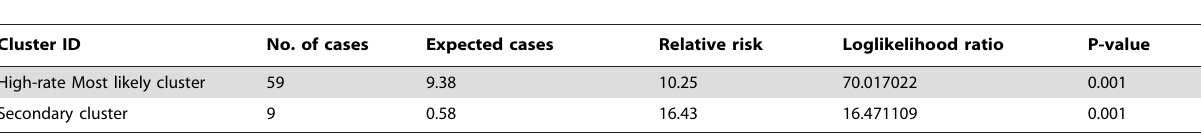
Table 2. Space-time clusters with significant higher and lower rates of TB in Dabat, Ethiopia 2012.